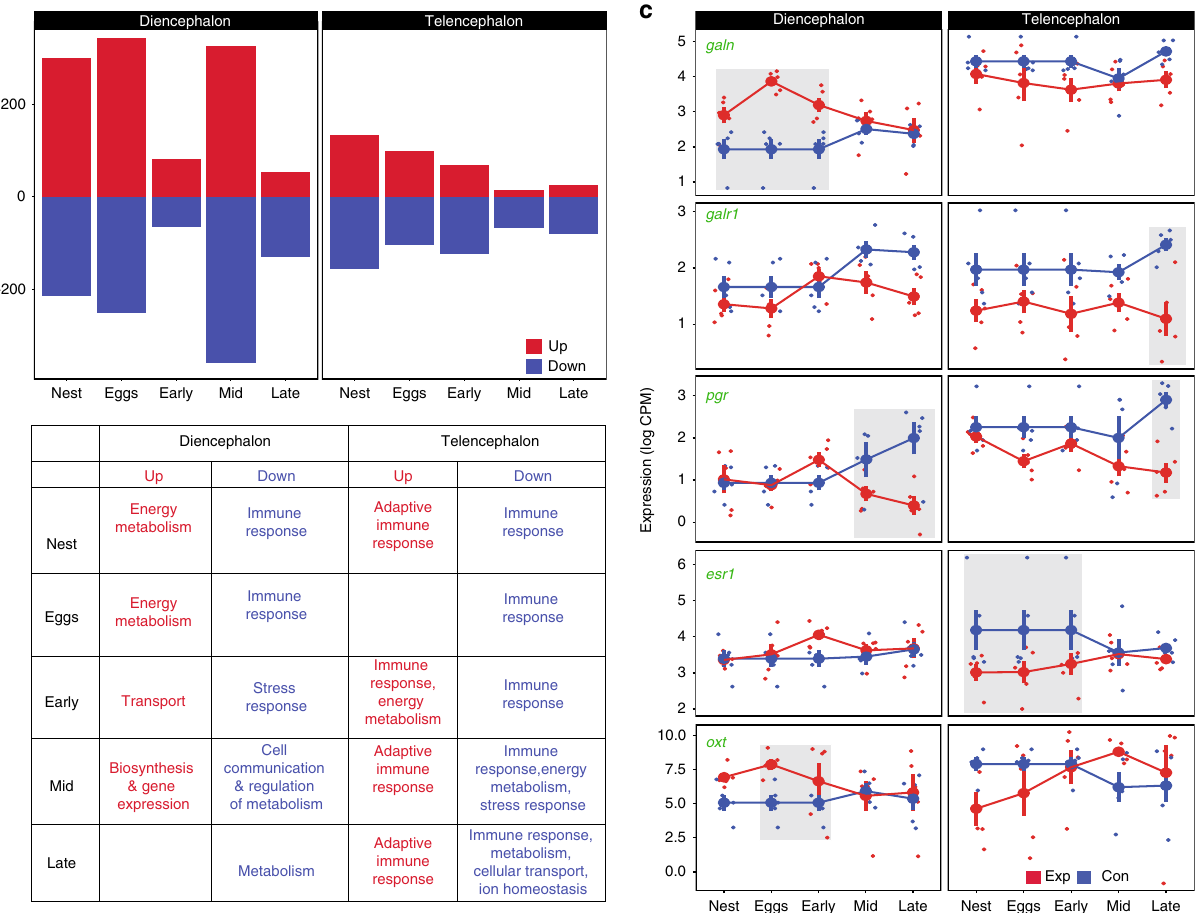
Fig. 1 Neurogenomic dynamics of paternal care. a The number of up- and down-regulated differentially expressed genes (DEGs) at each stage of paternal care in diencephalon and telencephalon. b Summary of GO-terms that were enriched in up- and down-regulated genes at each stage in the two brain regions. c The expression pro fi le of candidate genes related to maternal care (galanin, galanin receptor 1, progesterone, estrogen receptor 1, oxytocin) across stages, with expression in the two brain regions plotted relative to the appropriate circadian control group; data points represent individual samples with means and s.e.m. indicated. Statistical signi fi cance of these genes was assessed as a pairwise contrast between a stage and its control (see Supplementary Data 1 for full list of genes; source data are in GEO GSE134508) using negative binomial distribution with generalized linear models in edgeR. Boxes surround means that are statistically different between the control and experimental condition within the (Fig. 1b, Supplementary Data 2). The expression pro fi le of particular candidate genes related to parental care are in Fig. 1c, with statistically signi fi cant differences between the control and experimental condition within a stage indicated. Altogether these patterns suggest that paternal care involves signi fi cant neuroge- nomic shifts in stickleback males.